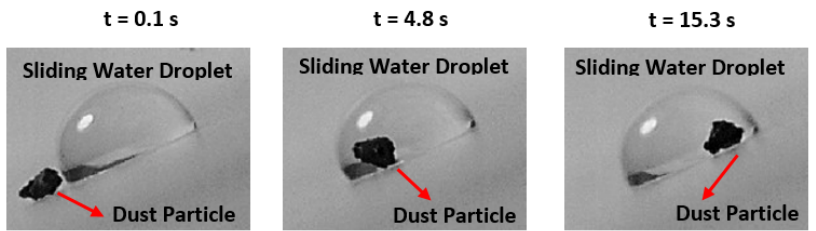
Figure 9. Optical images of sliding water droplet and dust particle over silicon oil impregnated surface. Red arrow shows the location of dust particle on the surface and after t = 4.8 s dust particle is picked up by the sliding water droplet.